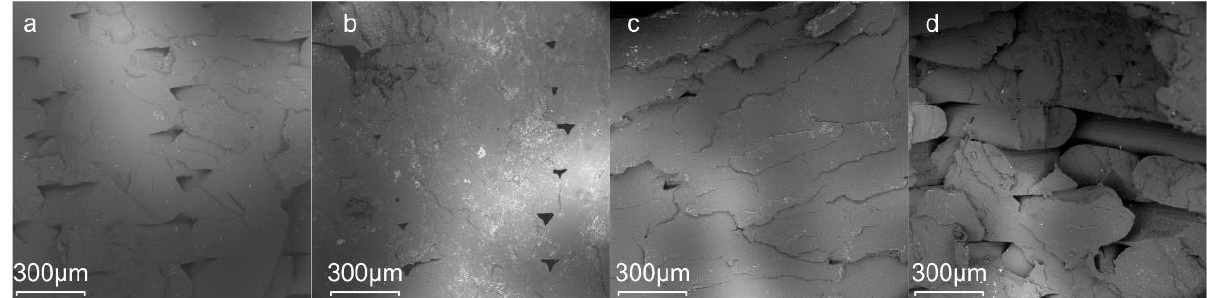
Figure 9. SEM microstructure of the cross section (infill area) of the tensile fracture surface for ( a ) PLA neat, ( b ) PLA/J1, ( c ) PLA/J2, and ( d ) PLA/J3.